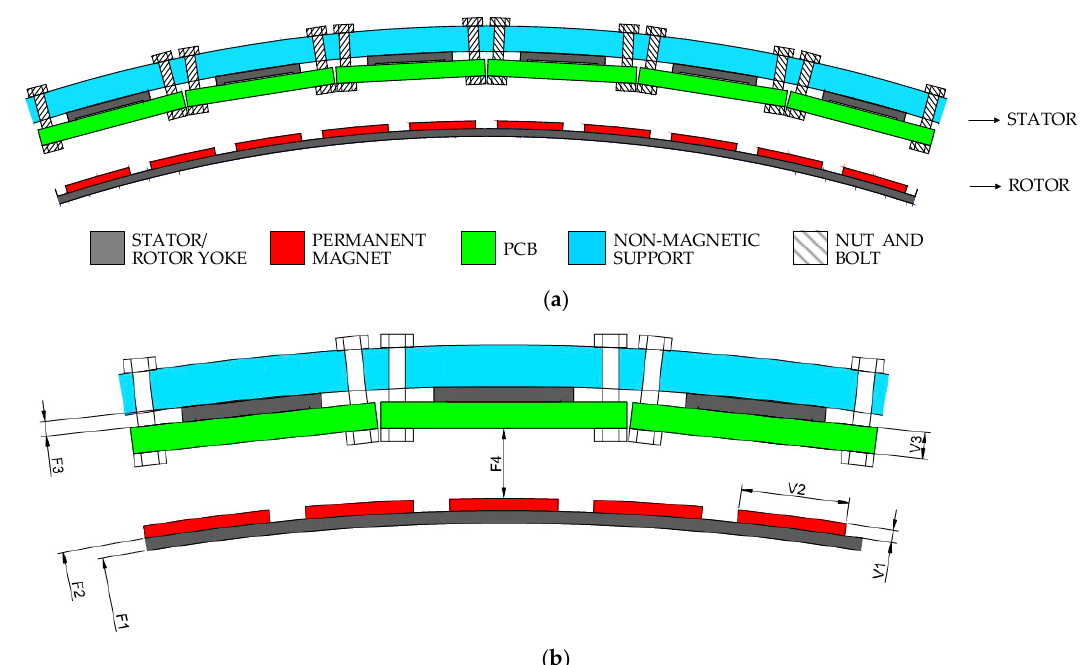
Figure 10. Sketch of one module of the annular PM machine ( a ) and detail of the main geometric parameters ( b ). The quantities F i are fixed, the quantities V i are varied during the optimization run.